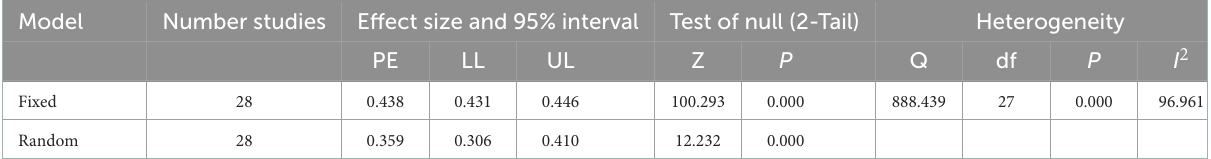
TABLE 1 Heterogeneity test results (the I 2 statistic of 96.961% implies high heterogeneity among the effect values, therefore, random effect model is suitable for this meta-analysis).